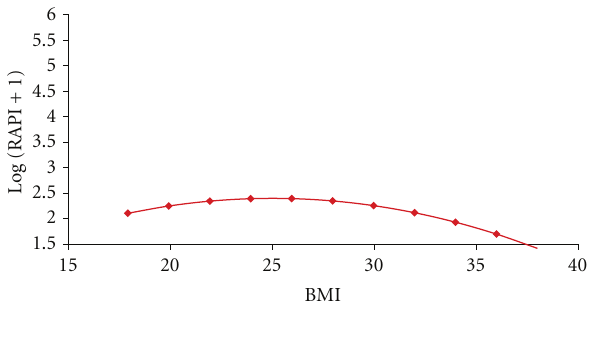
Figure 2: Association of RAPI to BMI.